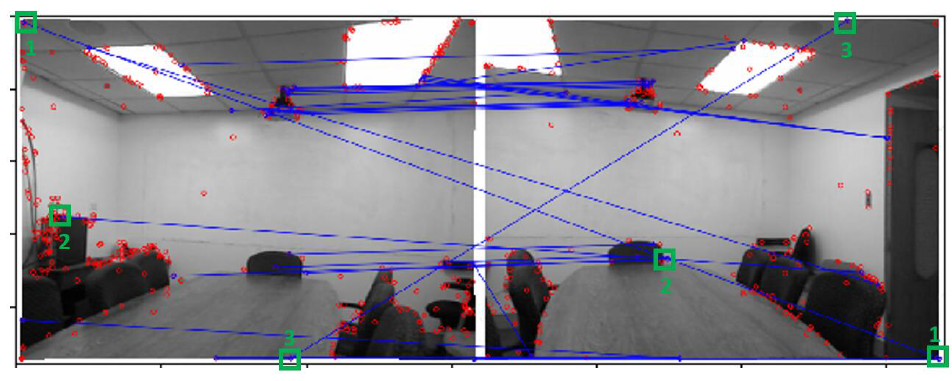
Figure 2. Mismatching results of the traditional SIFT algorithm (keypoint pairs 1, 2, and 3 marked in green